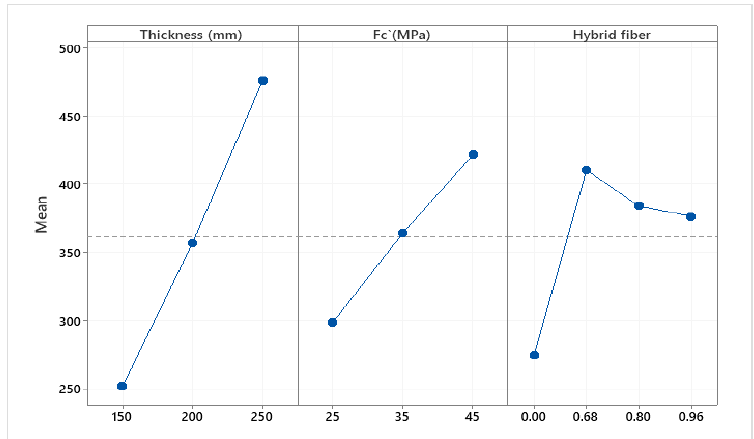
Figure 6. Main effects plot for ultimate load capacity Pu